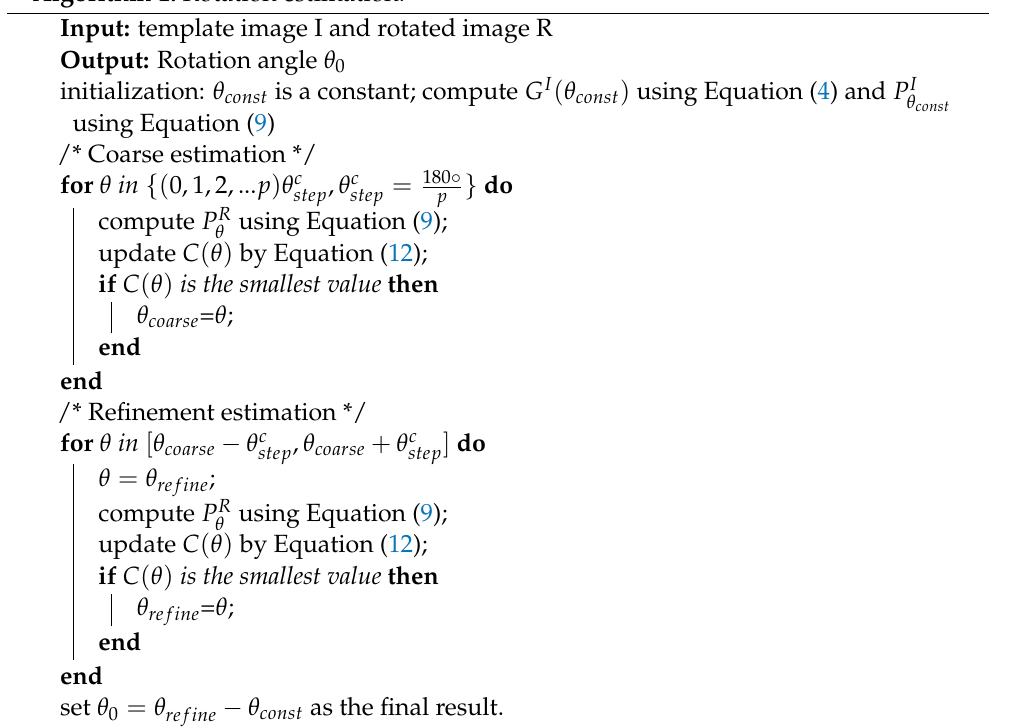
Algorithm 1: Rotation